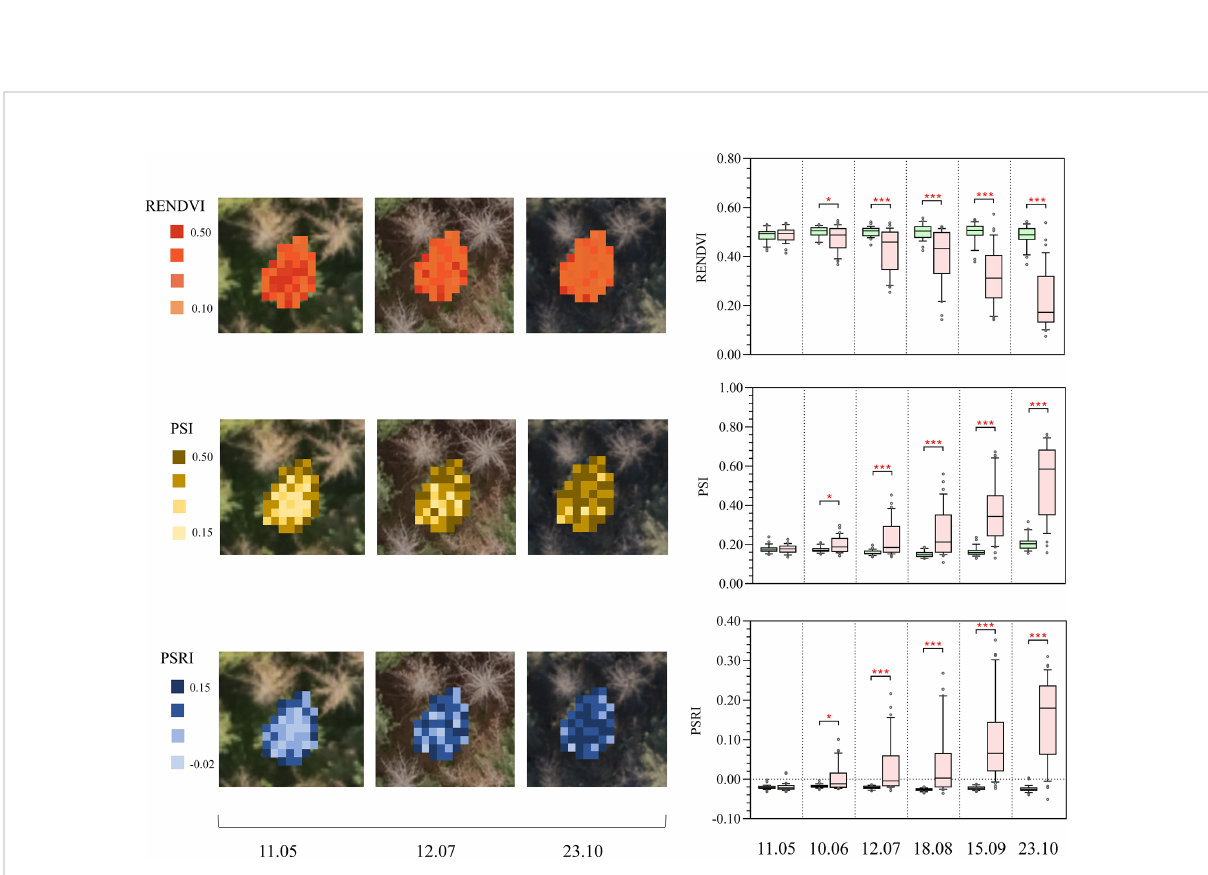
FIGURE 9 Rights: Boxplots showing temporal changes in Plant Senescence Re fl ectance Index (PSRI), Red Edge Normalized Difference Vegetation Index (RENDVI), and Plant Stress Index (PSI) derived from tree canopy spectra (infested trees are in pink, control trees are in green). The symbol * indicates signi fi cant differences, with * and *** indicating differences at p < 0.05, p < 0.01, and p < 0.001 levels, respectively. Left: associated maps of PSRI, RENDVI and PSI, showing the within-crown variation of features on 11 May, 12 July and 23